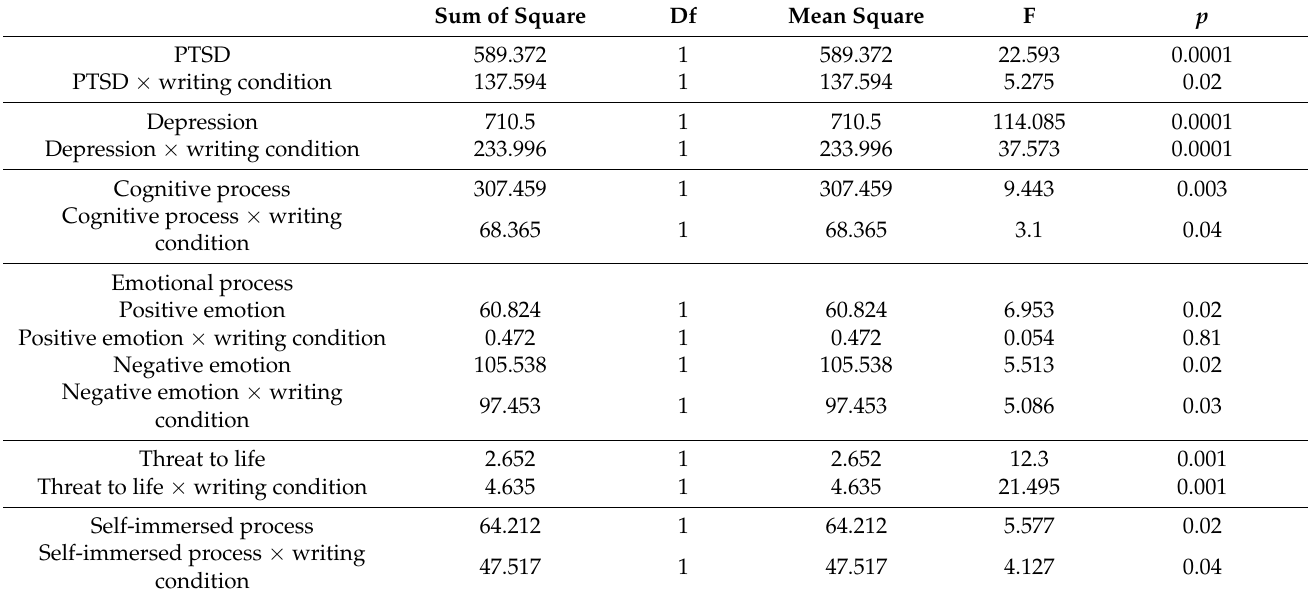
Table 3. Repeated-measure